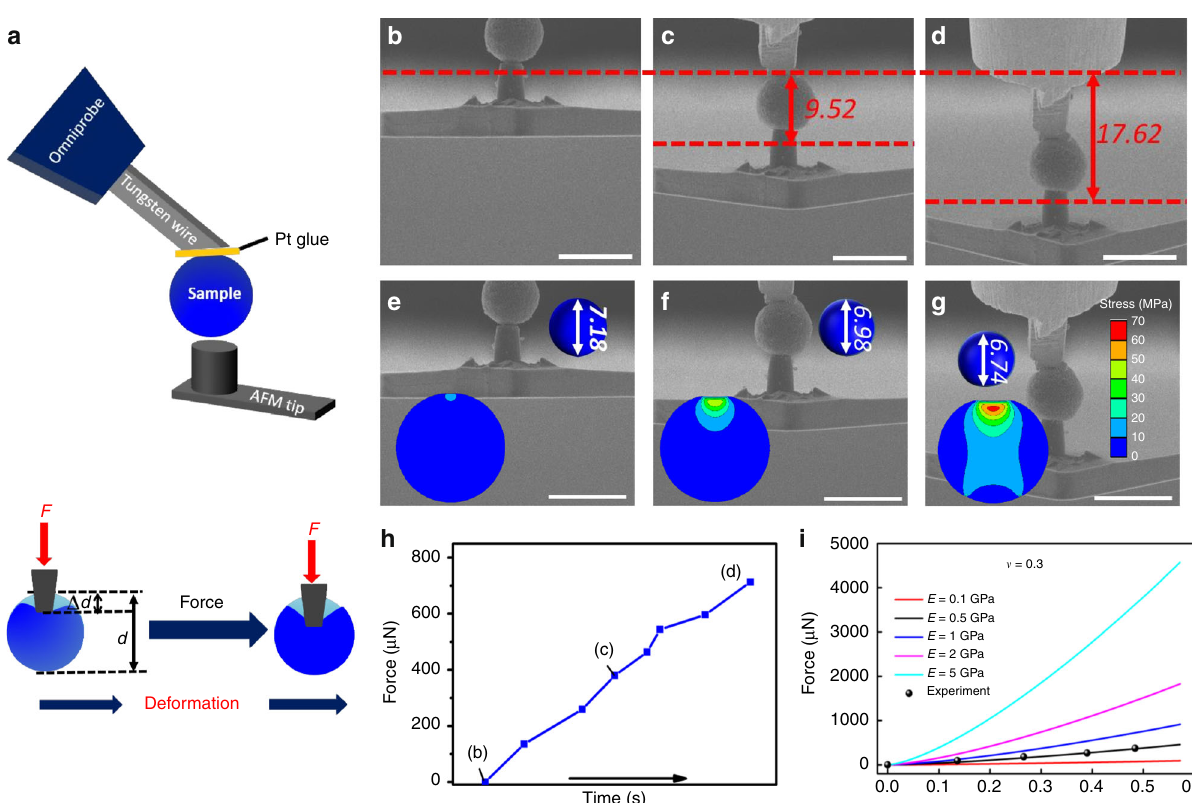
Fig. 3 Mechanical strength of CNT@Si@C microspheres. a Schematic of the in-situ AFM – SEM experiment for the mechanical strength measurement. b – d AFM tip displacement/cantilever de fl ection of a typical CNT@Si@C sphere under an applied force: b beginning of the pressing; c the middle point of the pressing; d right before the breakdown of the particle. e – g The different deformation states of a CNT@Si@C sphere: e Δ d = 0.05 µ m; f Δ d = 0.27 µ m; g Δ d = 0.49 µ m, and the corresponding distribution of the von Mises stress (MPa) from FE simulation (inset) with the Young ’ s modulus 0.5 GPa and the Poisson ratio 0.3. Scale bar for Fig. 3b – g is 10 µ m. The unit for the numbers in the fi gures is µ m. h The curve of force vs time during b to d . i Experimental data (dots) and FE simulation curve of the force vs particle deformation Δ d with the Poisson ratio 0.3 and different Young ’ s